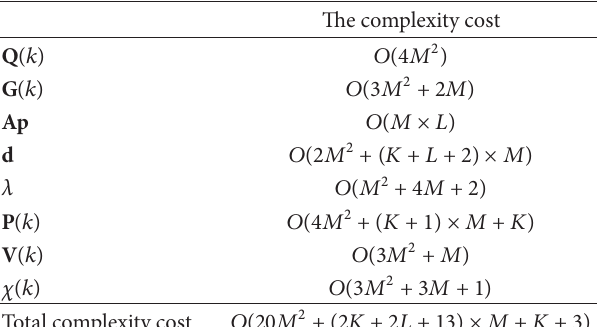
Table 2: The complexity cost of the proposed